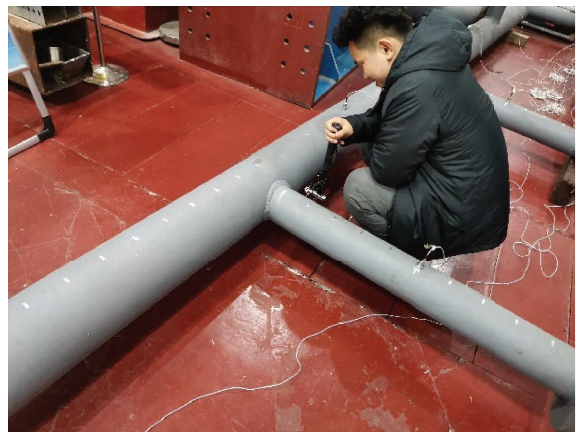
Figure 9: Modal test of pipeline systems under force hammer loading. Table 2: Measured natural frequencies of the pipeline model (Hz).